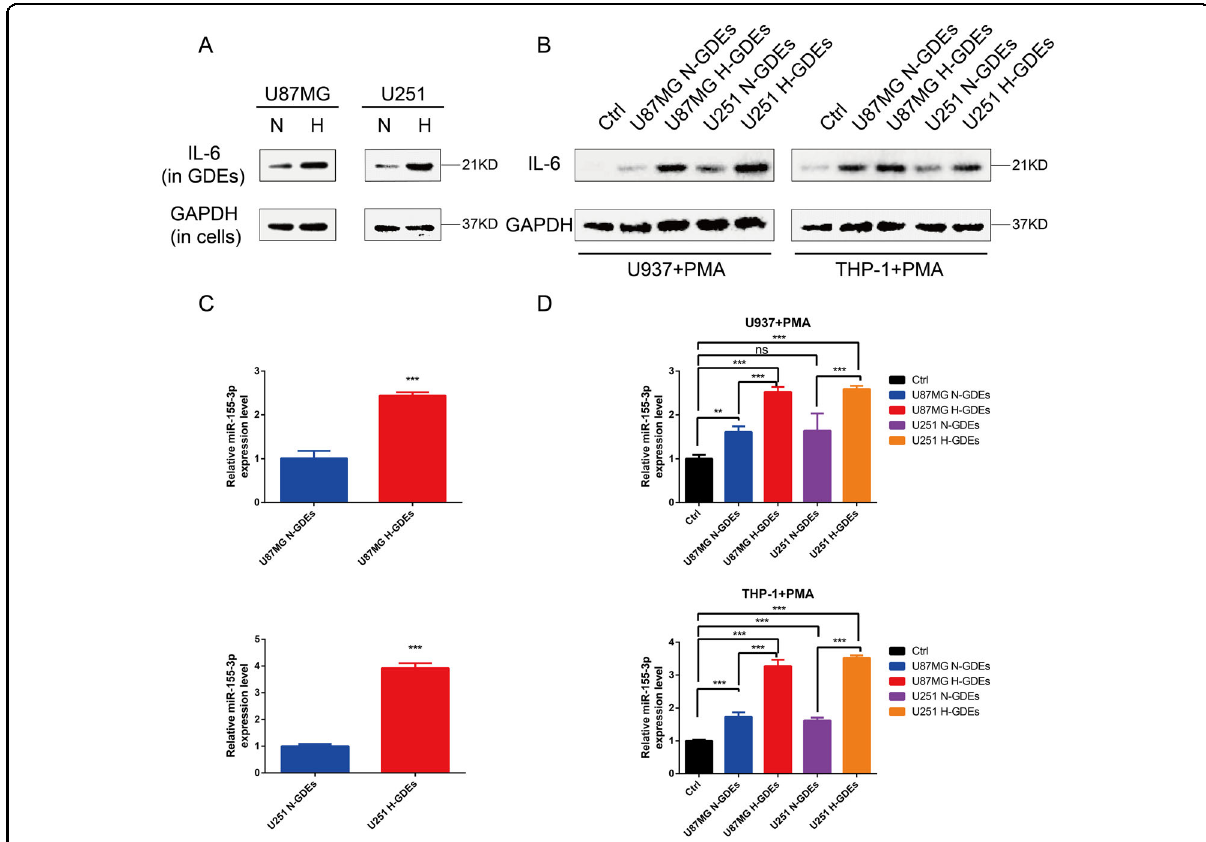
Fig. 4 IL-6 and miR-155-3p are highly expressed in H-GDEs and delivered to macrophages via exosomes. A The expression levels of IL-6 in normoxic and hypoxic exosomes of U87MG and U251 glioma cell lines were determined by western blot. B The expression levels of IL-6 in macrophages treated with PBS, N-GDEs or H-GDEs were determined by western blot. C The expression levels of miR-155-3p in normoxic and hypoxic exosomes of U87MG and U251 glioma cell lines were determined by qRT-PCR. D The expression levels of miR-155-3p in macrophages treated with PBS, N-GDEs or H-GDEs were determined by